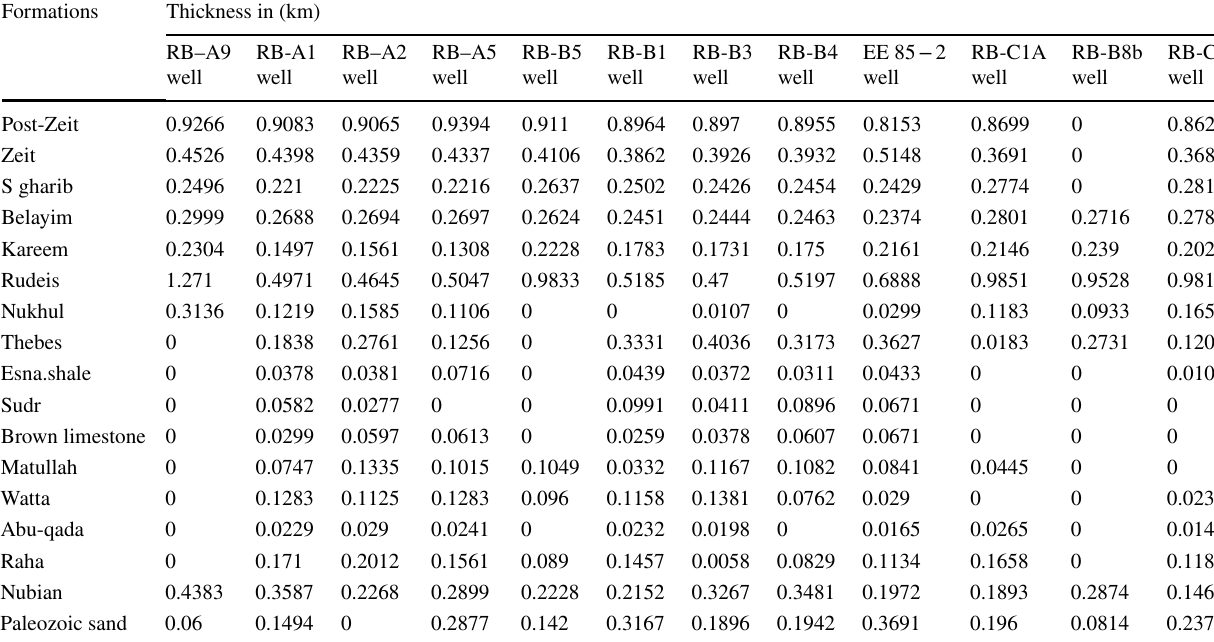
Table 2 Thickness of different sedimentary formations in the study area Formations